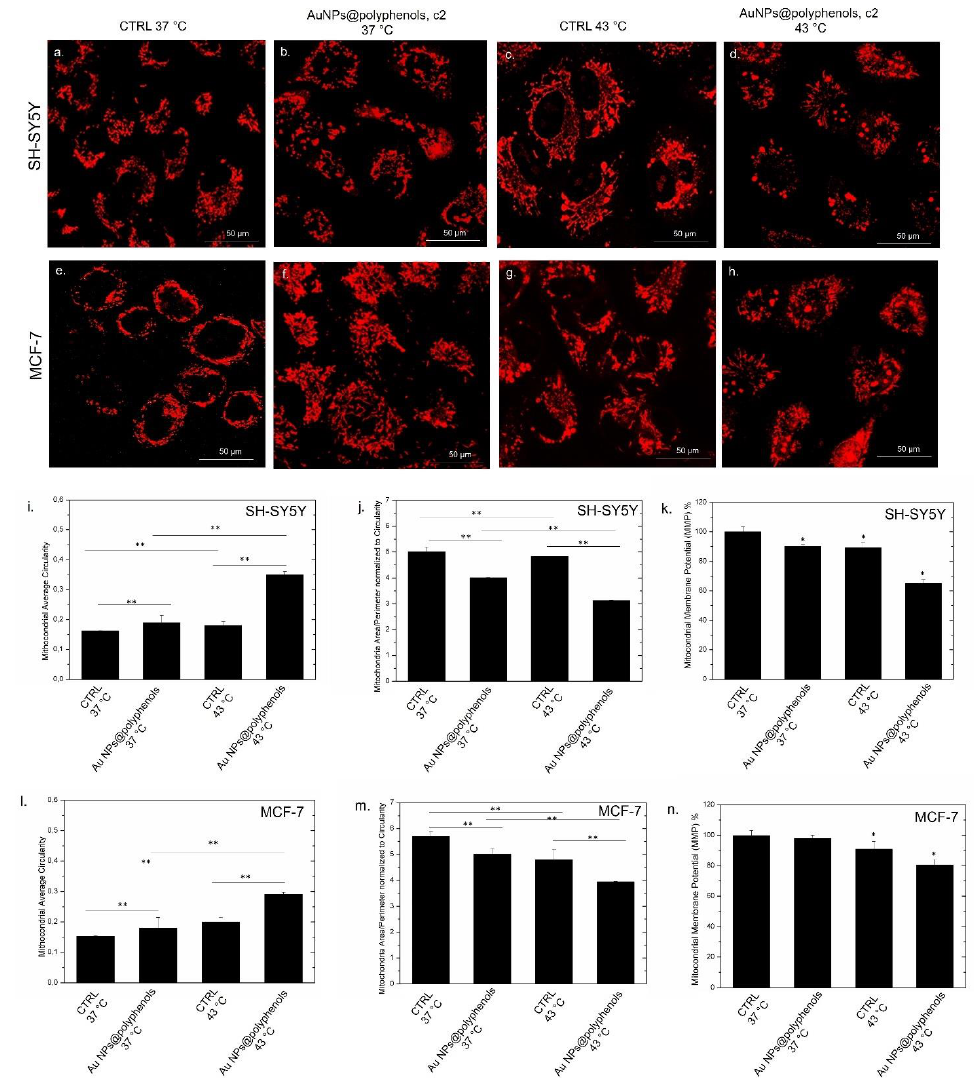
Figure 9. Confocal microscope acquisitions of SH-SY5Y and MCF-7 mitochondria labelled with MitoTracker™ Deep Red FM . Untreated cells ( a , e ), cells exposed to Au NPs@polyphenols at the concentration of c2 at 37 ◦ C ( b , f ), cells treated with 43 ◦ C ( c , g ), and cells incubated with Au NPs@polyphenols at the concentration of c2 at 43 ◦ C ( d , h ). The mean values and standard deviations of the mitochondrial average circularity of SH-SY5Y ( i ), MCF-7 ( l ), and mitochondria area/perimeter normalized to the circularity of SH-SY5Y ( j ) and MCF-7 ( m ) treated as in ( a – e ). The effect of Au NPs@polyphenols on the Mitochondrial Membrane Potential (MMP) level in SH-SY5Y ( k ) and MCF-7 cells ( n ) after 24 h and 48 h of exposure to two doses (c1 and c2) of Au NPs@polyphenols at 37 ◦ C and 43 ◦ C, following the procedure described in the section, Materials. After 48 h, the cells were incubated with JC-1, and the fluorescence of the cells from each well was measured and recorded. The percentage mitochondrial membrane potential of nanoparticle-treated cells was expressed relative to the untreated control cells. As a positive control (P), the cells were incubated with 100 µ M of valinomycin. The data are reported as the mean ± SD from three independent experiments; * p < 0.05, ** p < 0.001 compared with control ( n = 8). The data are presented as the mean ± standard deviation of three independent experiments:. Perturbations of the MMP, assessed by the JC-1 assay, were found to be particularly evident when the Au NPs@polyphenols and heat were used simultaneously. In good agreement with previous experiments, it was clear that there was a connection between Ca 2+ overload, oxidative stress, and mitochondria